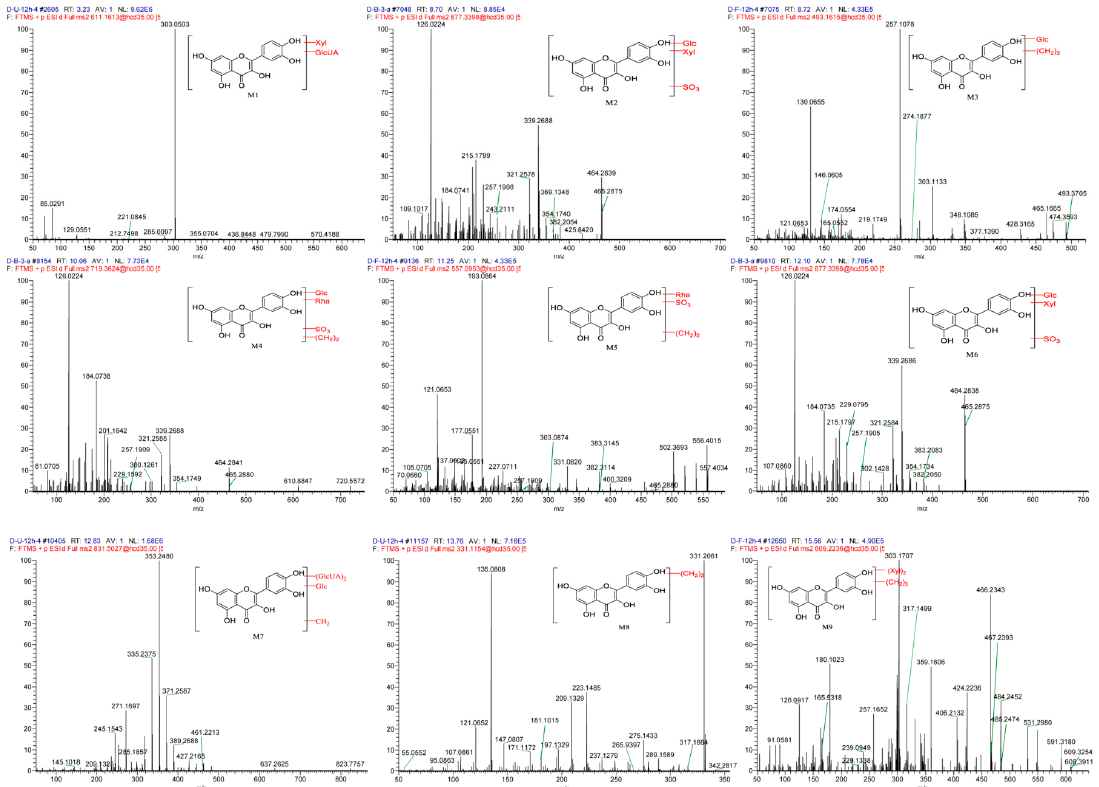
Figure 4. MS / MS spectra of novel metabolites detected in beagle dog urine, feces, and Figure 4. MS/MS spectra of novel metabolites detected in beagle dog urine, feces, and plasma.